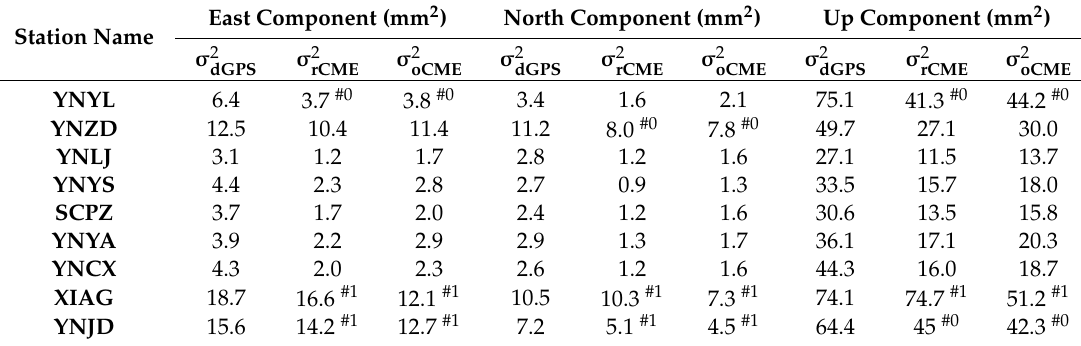
Figure 6. The variances of postfit residuals for ( a ) east, ( b ) north, and ( c ) up components. The bars in blue, green, and red denote variances of the postfit residuals for the original time series and the time series after oCME and rCME filtering, respectively. Except for XIAG and YNYL, most of the variances after rCME correction are less than those corrected with oCME for all three components. The numbers labeling the horizontal axis denote the stations listed in Table 1.